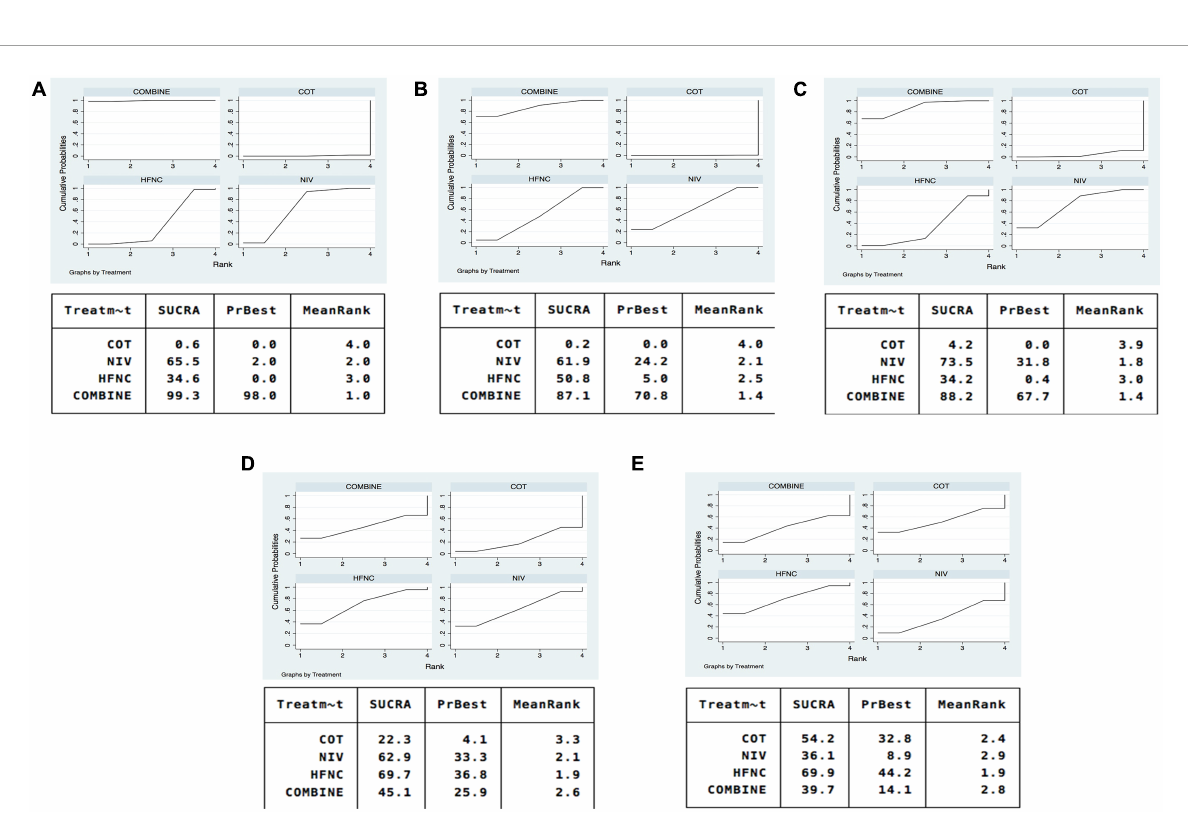
FIGURE4 SUCRA of oxygen therapies for reintubation rate, respiratory failure, ICU mortality, ICU stay, and LOS. (A) Reintubation; (B) respiratory failure; (C) ICU mortality; (D) ICU stay; (E) LOS. NIV, non-invasive ventilation; COT, conventional oxygen therapy; HFNC, high-flow nasal cannula; SUCRA, surface under cumulative ranking